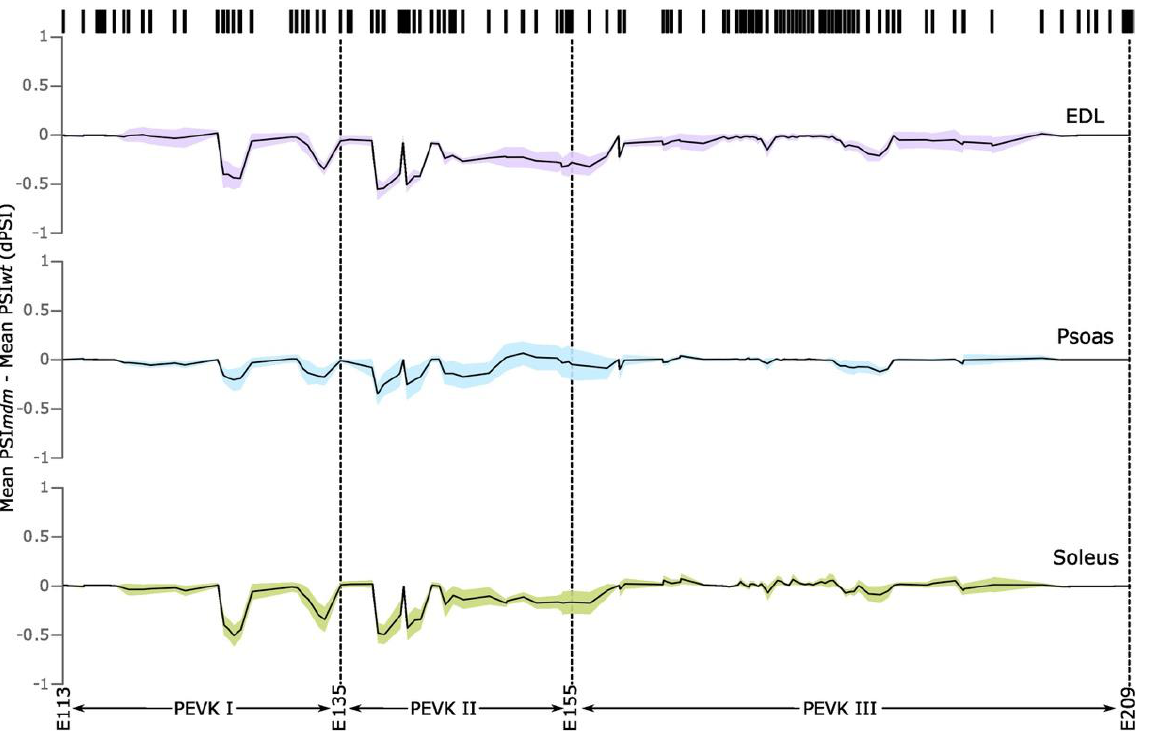
Figure 3. ∆PSI plots for EDL ( purple), psoas (blue), and soleus (green) highlighting that the major splice variation occurs in the PEVK region. The PSI values of the mdm titin exons were subtracted from the WT PSI values to determine the PSI difference (dPSI). Negative PSI values indicate a higher rate of exon inclusion in WT titin.